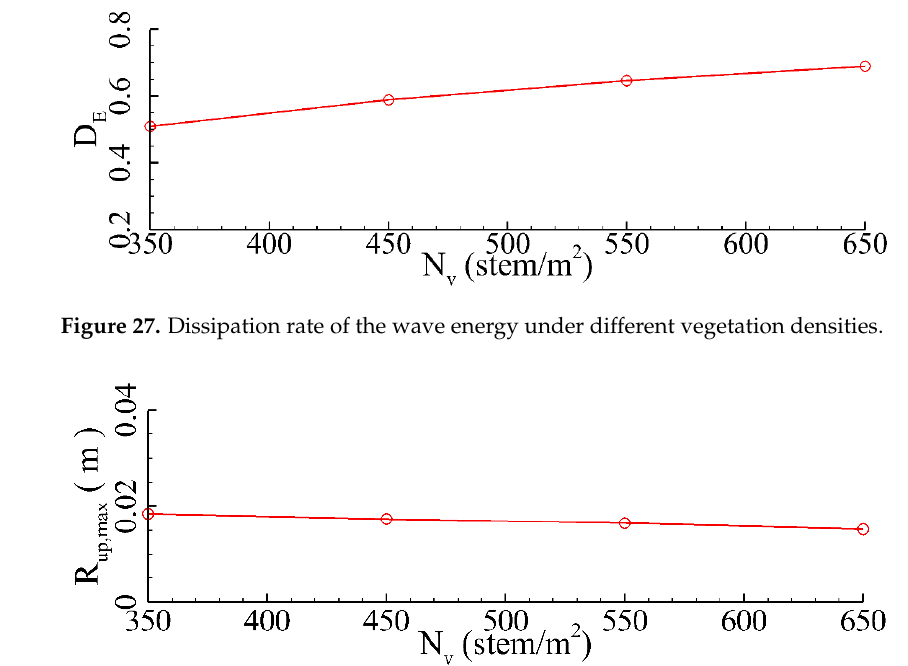
Figure 26. Dissipation rate of the local maximum wave height under different vegetation densities.